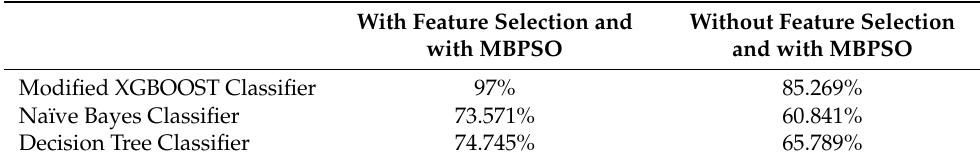
Table 4. Accuracy of different classifiers with and without feature selection. With Feature Selection and with